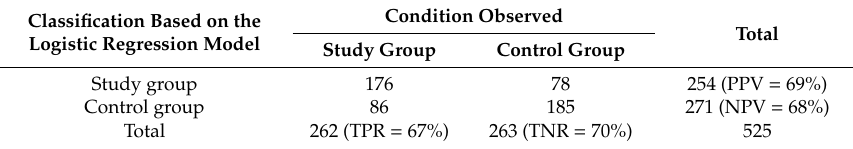
Table 5. Results of the classification of patients in the studied population.